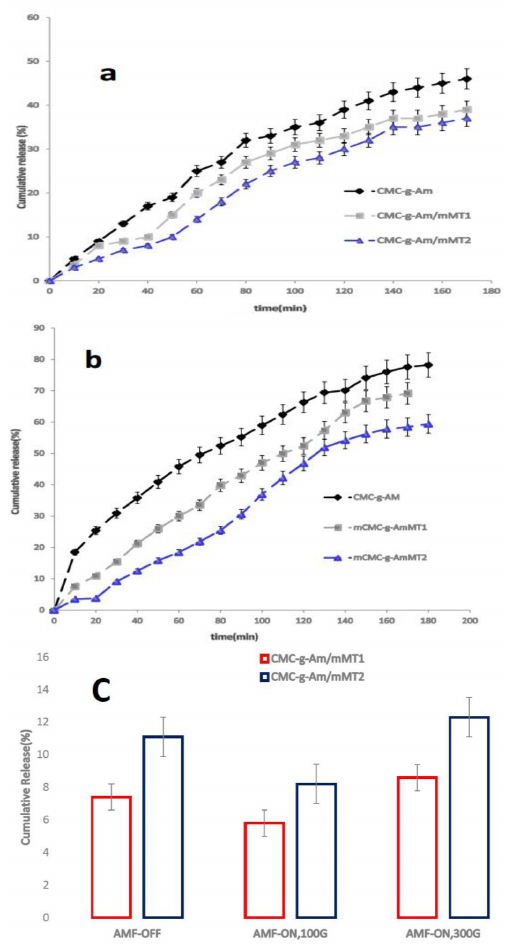
Fig. 5. Drug release profiles of nanocomposite hydrogels in a buffered solution with pH 7.4; (a) and pH 1.2 (b) (c) influence of external AMF on the drug release profiles of magnetic hydro- gels at pH 7.4. (Mean ± 3,